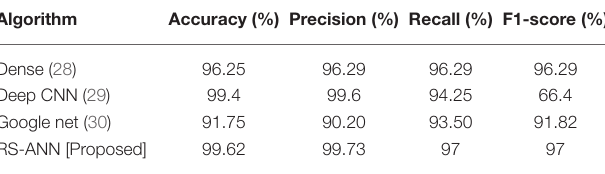
TABLE 2 | Comparison of traditional methods with proposed method.